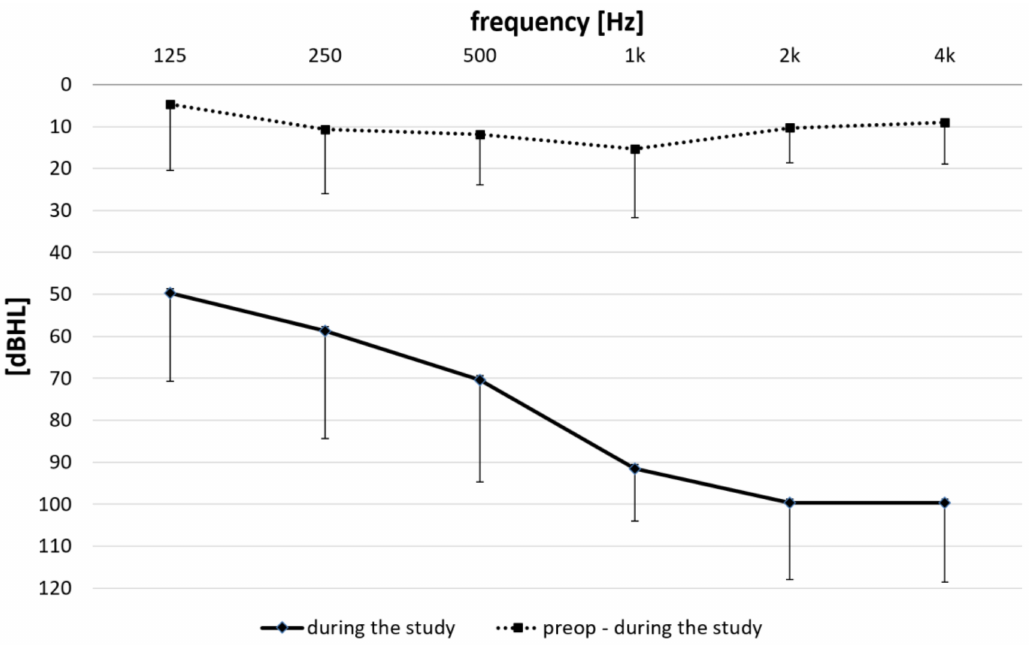
Figure 2. The mean and standard deviation for the postoperative audiogram (squares connected with solid line) obtained at the time of the study and the measured difference between the values obtained immediately before the cochlear implant surgery and at the time of the study (squares connected dotted line) for all subjects ( n =